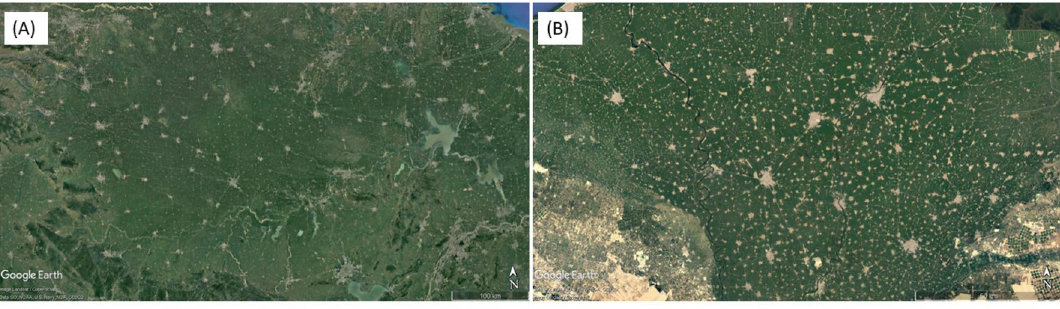
Figure 7. ( A ) Settlement pattern of the North China Plane, and ( B ): of the Nile delta in Egypt (Source: Google Earth Pro 7.1, accessed on